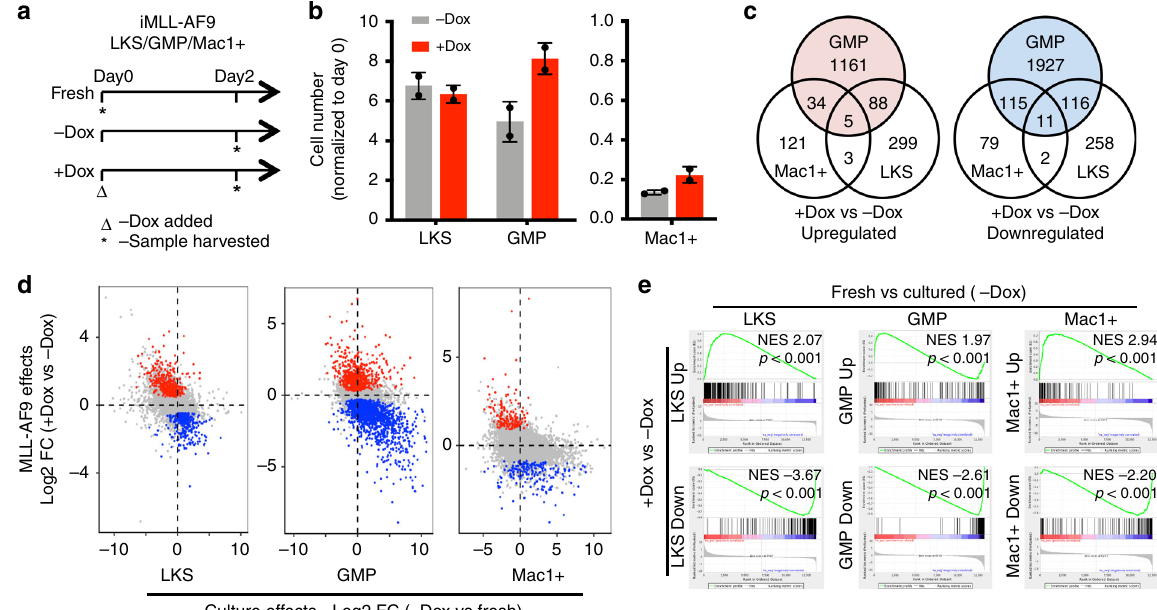
Fig. 5 The primary gene expression changes in response to MLL-AF9 induction is cell context dependent. a Work fl ow showing iMLL-AF9 LKS, GMP, or Mac1 + cells after their isolation on day 0 (fresh), or treated + / − Dox for 2 days. b Proliferation rates of respective cell types during 2 days of culture + / − Dox; n = 2, error bars represent s.d. c Venn diagram showing little overlap among up/downregulated DEGs from LKS, GMP, and Mac1 + cells. Cell type-speci fi c DEGs ( p < 0.05) were de fi ned between the respective cells treated + / − Dox. d Scatter plot showing culture-induced gene expression changes ( − Dox vs fresh) vs MLL-AF9-induced changes ( + Dox vs − Dox) in three cell types. Blue dots represent the oncogene downregulated DEGs; red dots represent the oncogene upregulated DEGs. e The Dox-induced DEGs, similar to those de fi ned in c but at p < 0.01, were queried against the gene expression changes occurred during culture in the respective cell types by GSEA. For GMPs, only the top 200 DEGs were